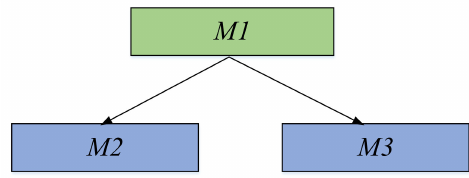
Figure 3. Best tree